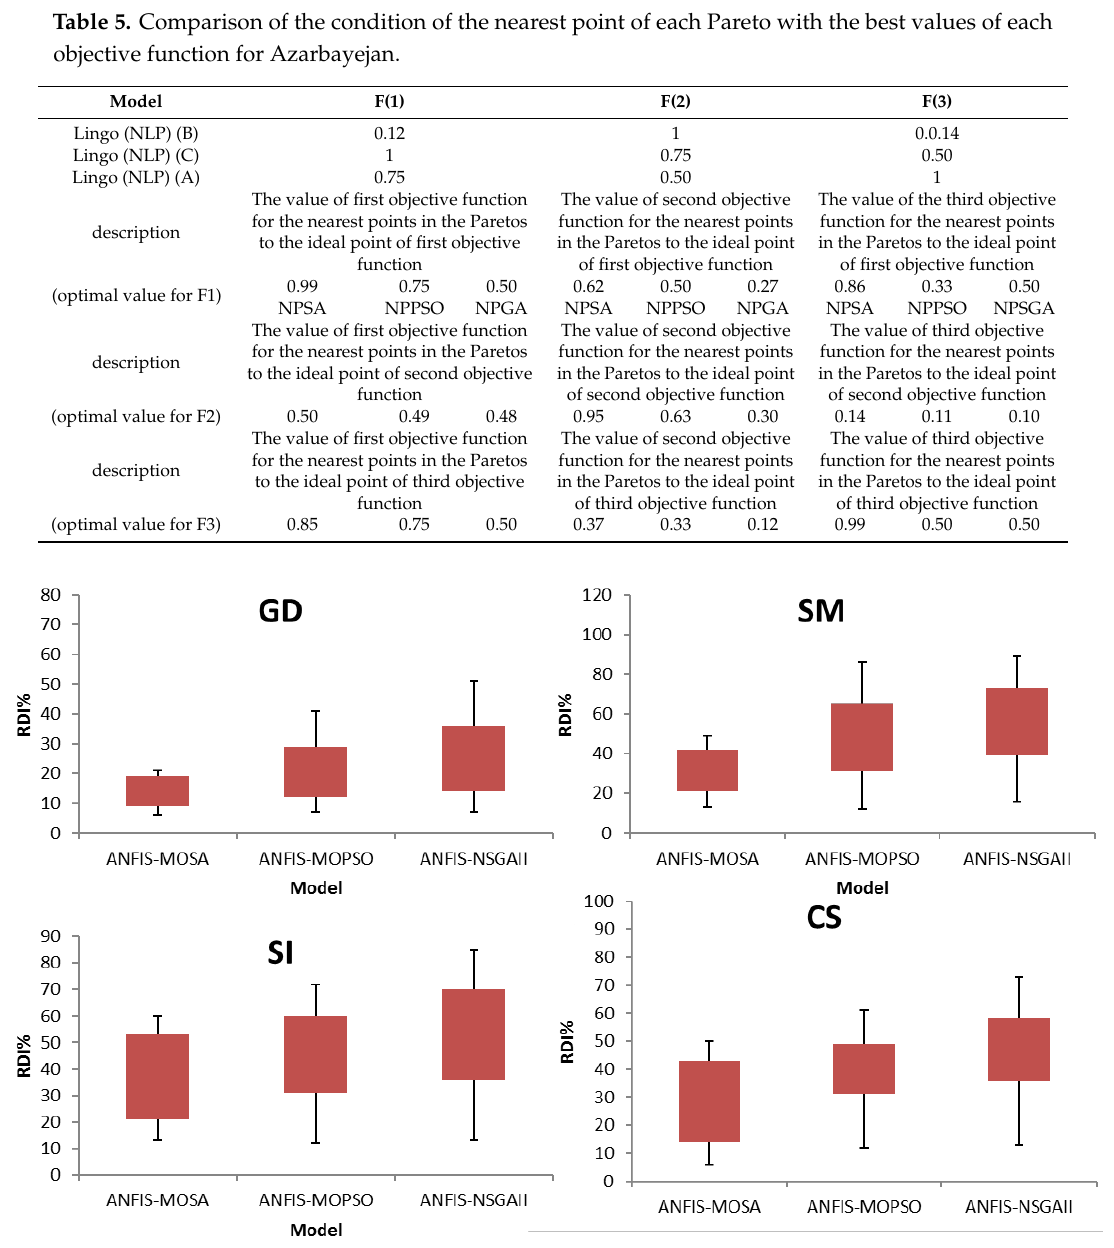
Figure 6. Computation of RDI for different indexes for Azarbayejan province. Table 5. Comparison of the condition of the nearest point of each Pareto with the best values of each objective function for Azarbayejan.